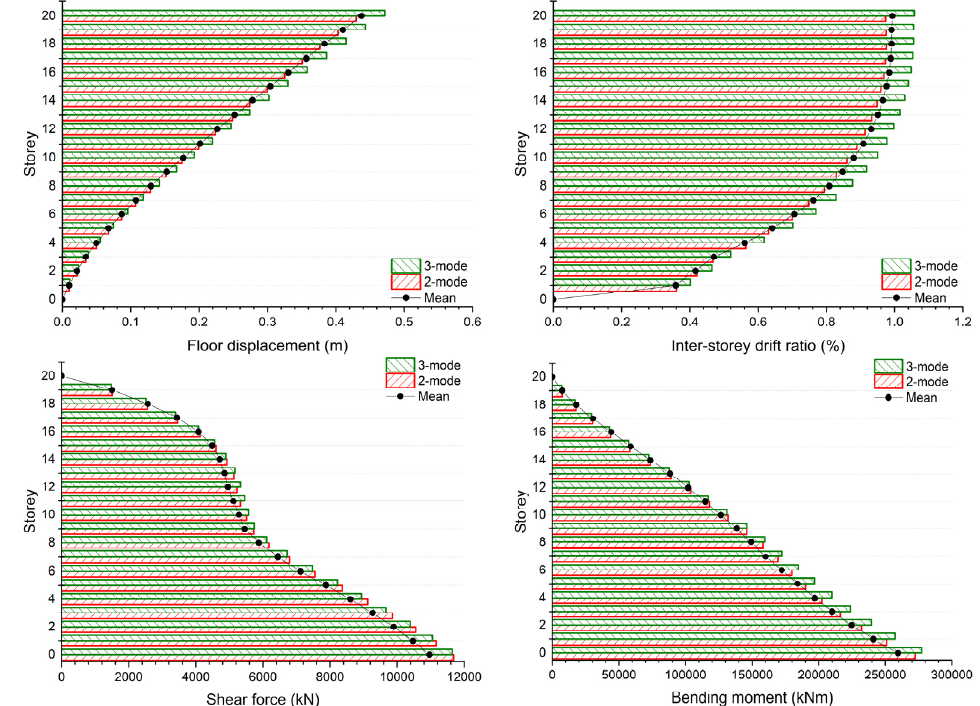
Figure 3. Comparison of the benchmark seismic demands and seismic demands computed by IGMs selected by MGMS procedures for motion set 6.